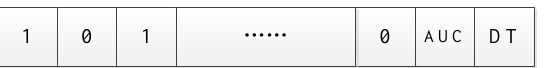
Figure 3. Initial solution example by SFS after encoding.